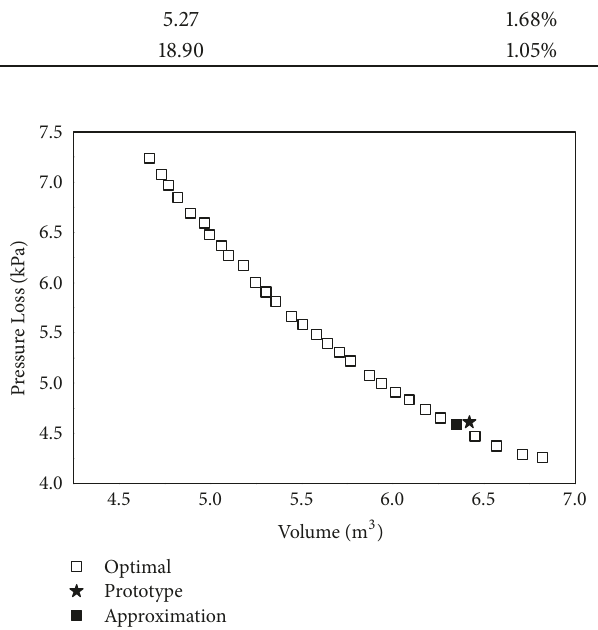
Figure 6: The distribution of original design and optimal